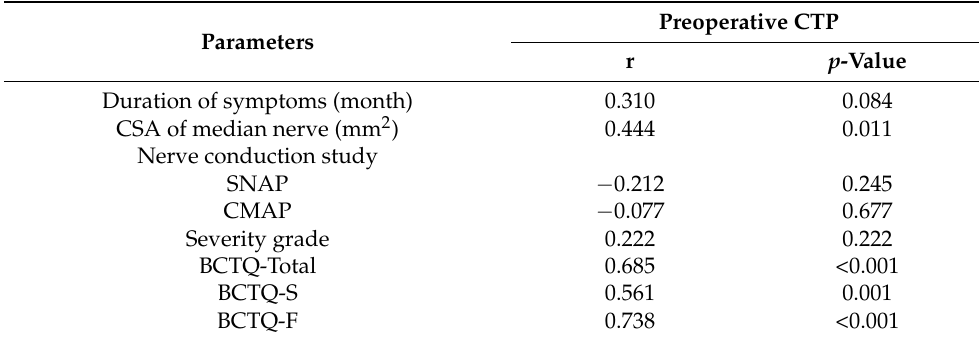
Table 2. Correlation between the preoperative carpal tunnel pressure (CTP) and the clinical presentations.